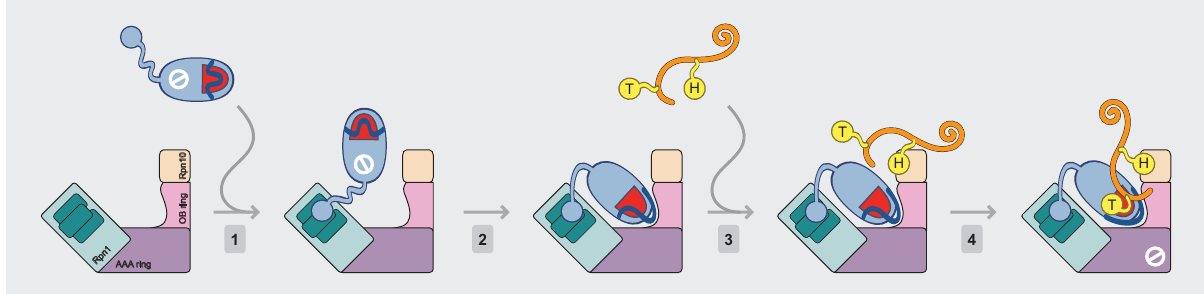
Fig. 6 Model for assembly of the Ubp6 catalytic complex. Free Ubp6 has an inactive conformation (slashed circle), its active site (red semioval) being blocked by BL1, BL2, and SL (blue wave). Step 1, Ubp6 and the proteasome are complexed via the Ubp6 UBL -Rpn1 interaction 2 . For clarity, only a fraction of proteasome subunits are represented. The Ubp6 UBL -Rpn1 interaction does not activate Ubp6 (ref. 35 ) but is proposed to promote association of the Ubp6 catalytic domain to Rpt1 through avidity (step 2). Ubp6-Rpt1 interaction in this context may partially destabilize the blocking loop network to